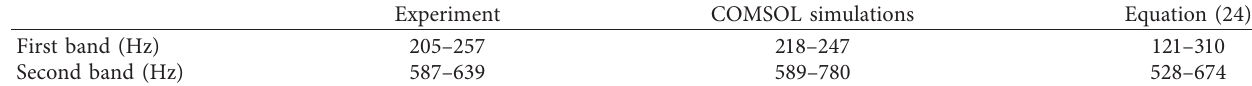
Table 2: Comparison between frequency bandgaps obtained using the experiment and models.